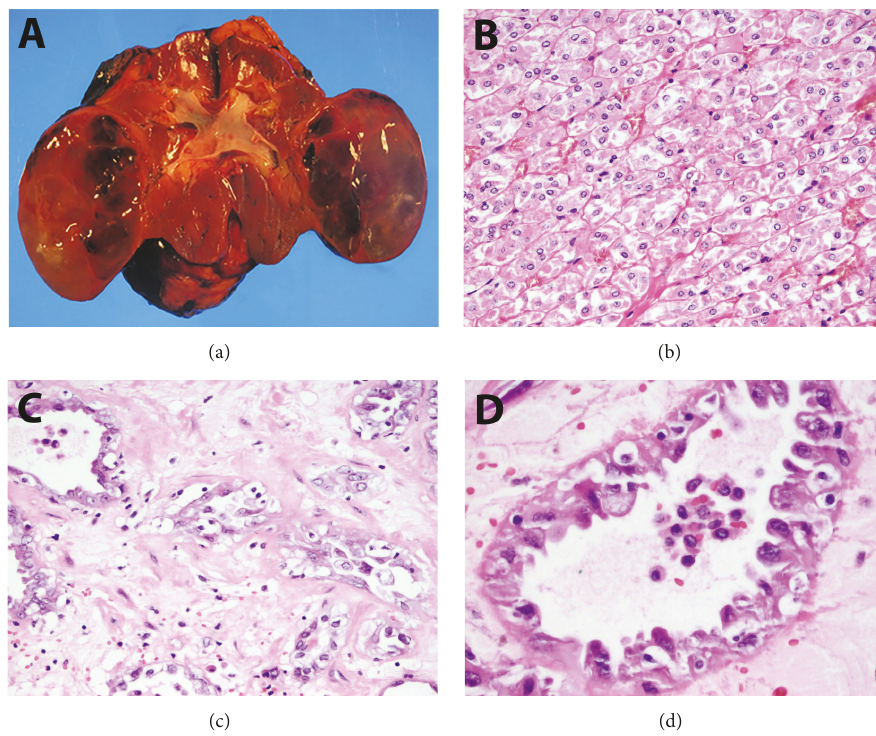
Figure 2: (a)-(d) Gross image and representative microscopic images: (a) Solid and cystic mass with a tan-brown cut surface involving the lower pole of the kidney. (b) Representative illustration from the dominant portion of the tumor, an eosinophilic variant of ChC containing relatively uniform cells with distinct borders and central nucleus. (c)-(d) A minor component of tumor with a tubulocystic morphology, marked cellular atypia, and hobnail nuclear features, in keeping with CDC, low, and high magnifications